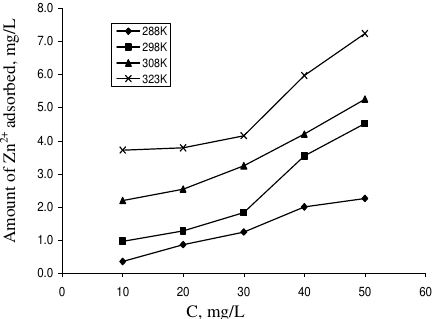
Figure 2. Variation of amount of Pb 2+ adsorbed by human hair with concentration of Pb 2+ in solution at various temperatures